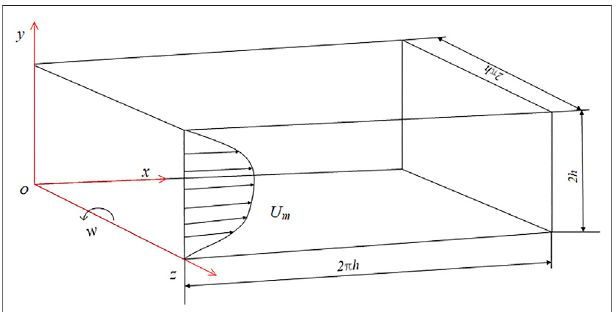
FIGURE 2 | Simulation domain of rotating channel fl